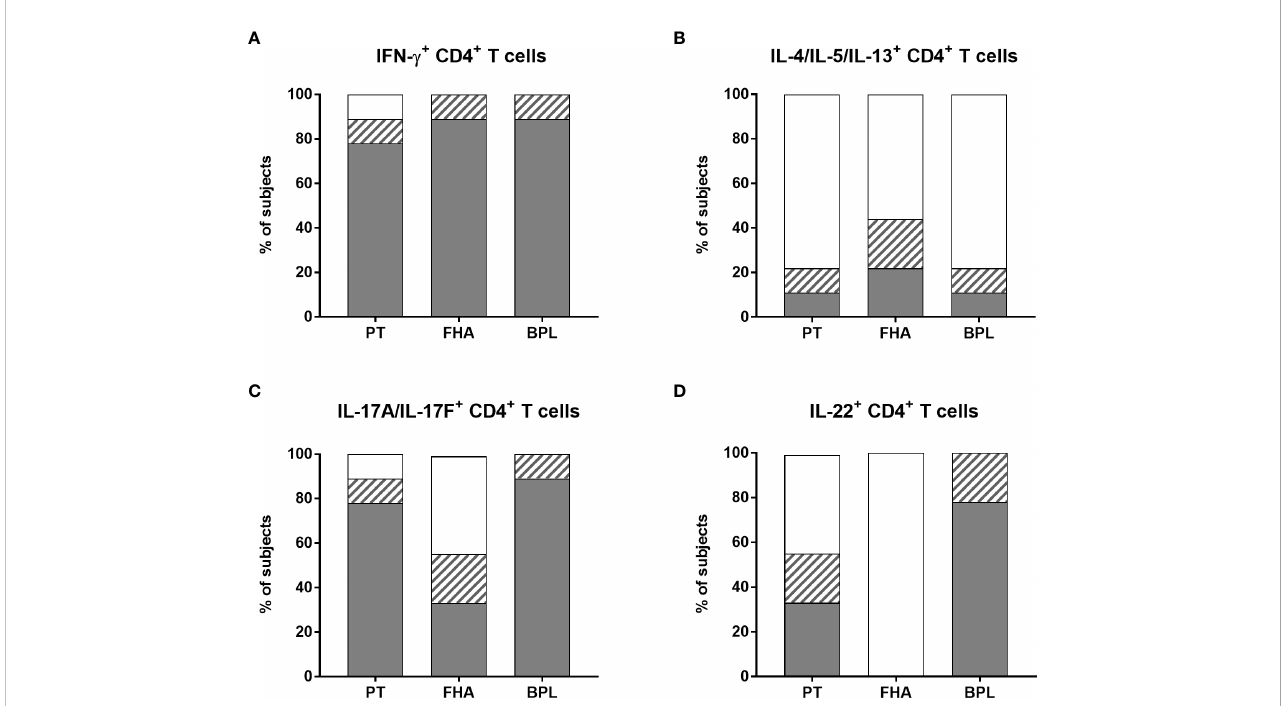
FIGURE 7 Distribution of non-responders and responders in the BpWB-ICS assay. The percentages of responders (grey areas), doubtful responders (hatched areas) and non-responders (white areas) to PT, FHA and BPL, based on their speci fi c (A) IFN- g -, (B) IL-4/IL-5/IL-13-, (C) IL-17A/IL-17F-, (D) and IL-22-positive CD4 + T cells were determined. The analysis was performed for seven adults (n°6-12), and two 5-6 years-old children, all recently aP vaccine boosted. The results obtained after staining of the Bp antigen-stimulated cryopreserved blood cells were considered after subtraction of the non-speci fi c background. The criteria shown in Table 2 were applied for the classi fi cation in responders, doubtful responders and